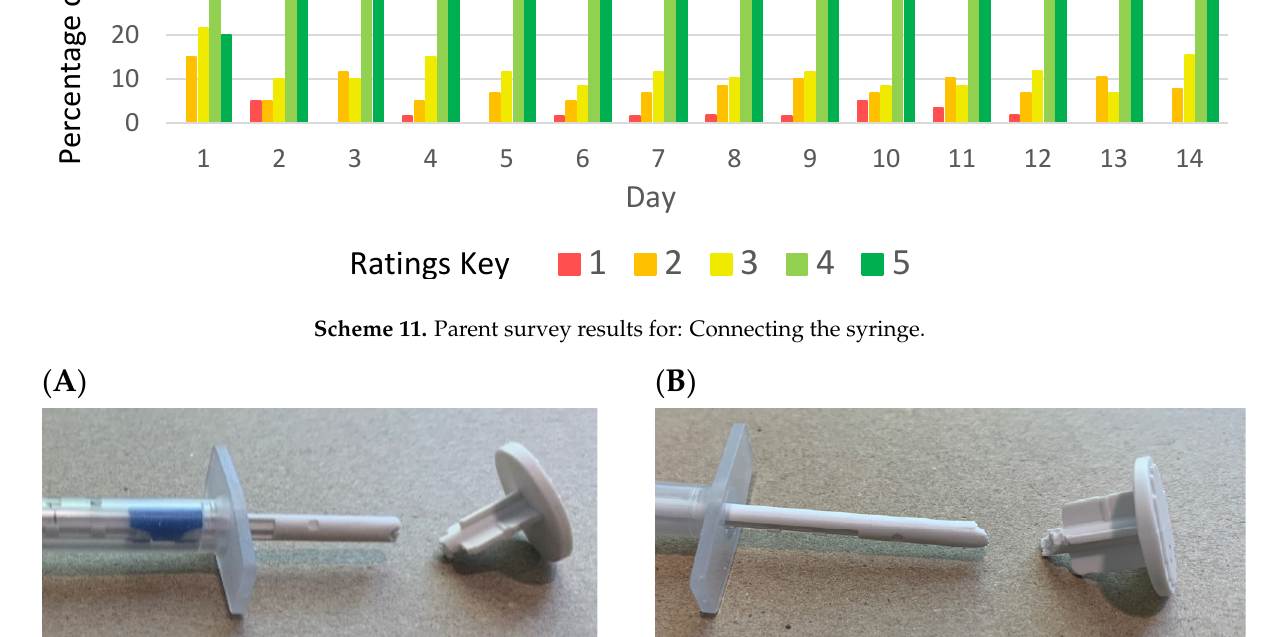
clumps of MP that would inhibit the flow into the